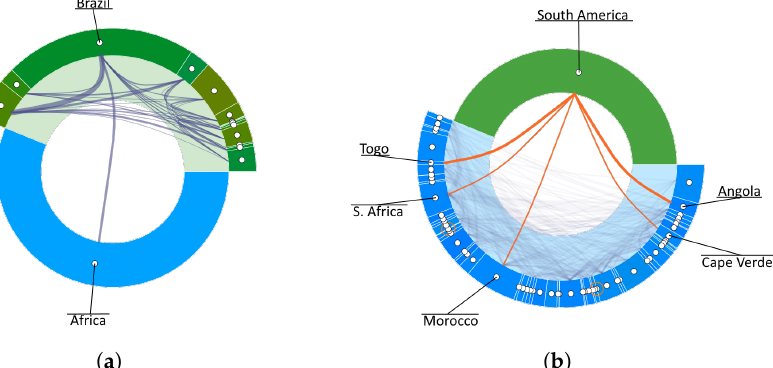
Figure 17. ( a ) Brazil is the only South American country with air routes to Africa . ( b ) Brazil connects with only 5 African countries: Morocco , South Africa , Togo , Cape Verde , and Angola